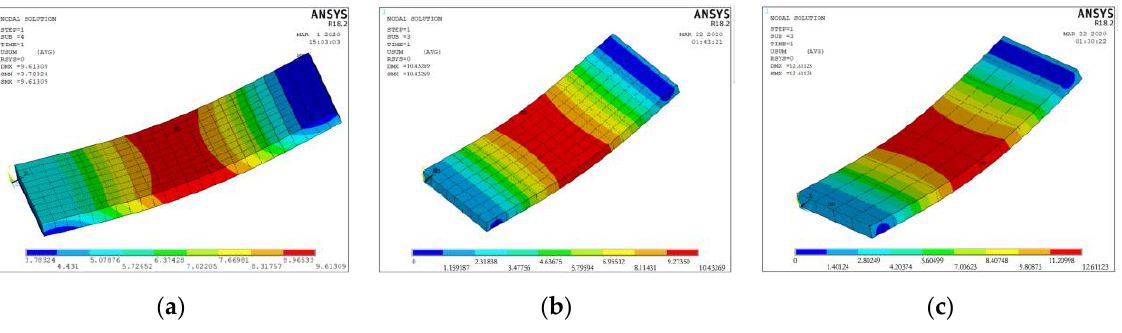
Figure 21. Deflection nephogram of composite floor with different cavity size: ( a ) 100, ( b ) 125 and ( c ) Appl. Sci. 2020 , 10 , 8444